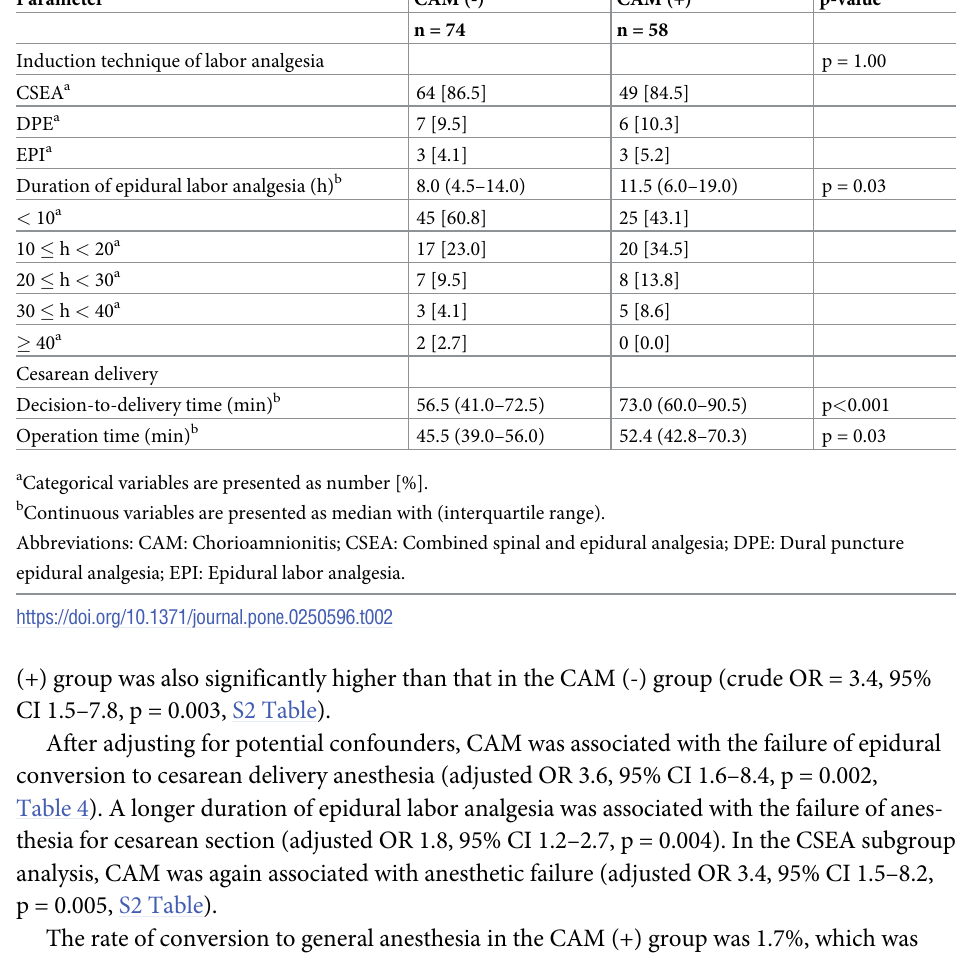
Table 2. Anesthetic management of epidural labor analgesia of the study population. Parameter CAM (-) CAM (+) p-value n = 74 n = 58 Induction technique of labor analgesia p = 1.00 CSEA a 64 [86.5] 49 [84.5] DPE a 7 [9.5] 6 [10.3] EPI a 3 [4.1] 3 [5.2] Duration of epidural labor analgesia (h) b